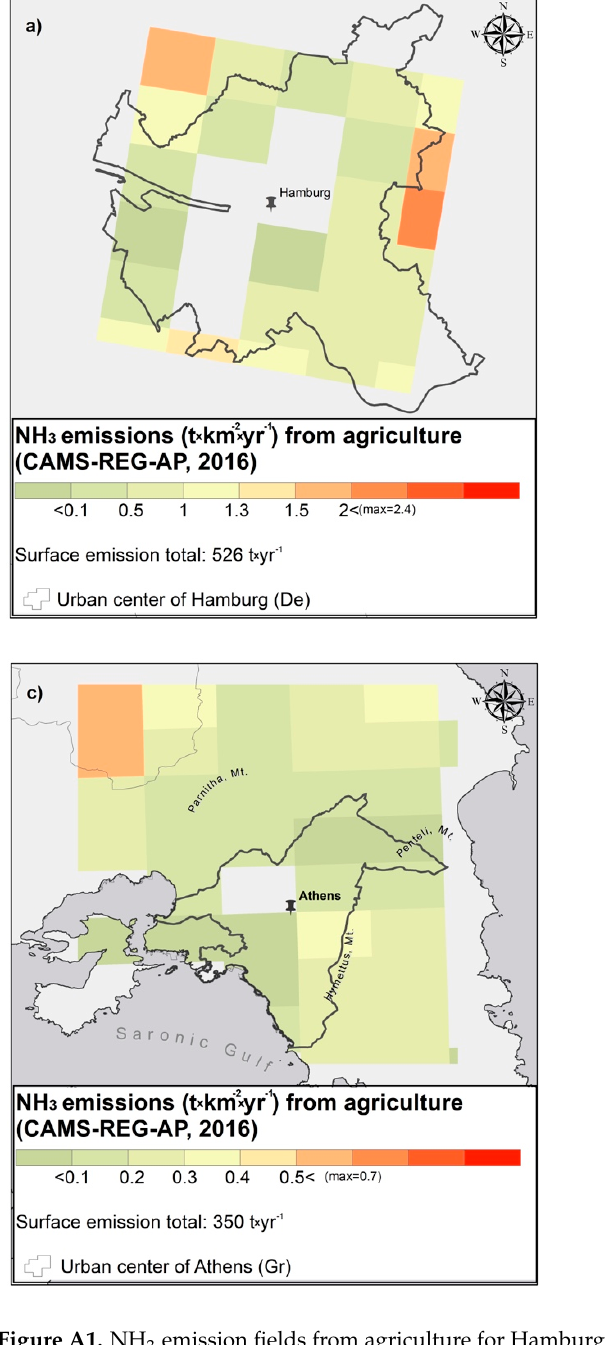
Figure A1. NH 3 emission fields from agriculture for Hamburg ( a , b ) and Athens ( c , d ), as originally provided by CAMS (left) and as produced by the UrbEm framework (right). Symbols and isopleths of the main proxies used per source type for the spatial disaggregation of CAMS toward the 1 km by 1 km grid are shown on the maps of the right column (UrbEm outputs).